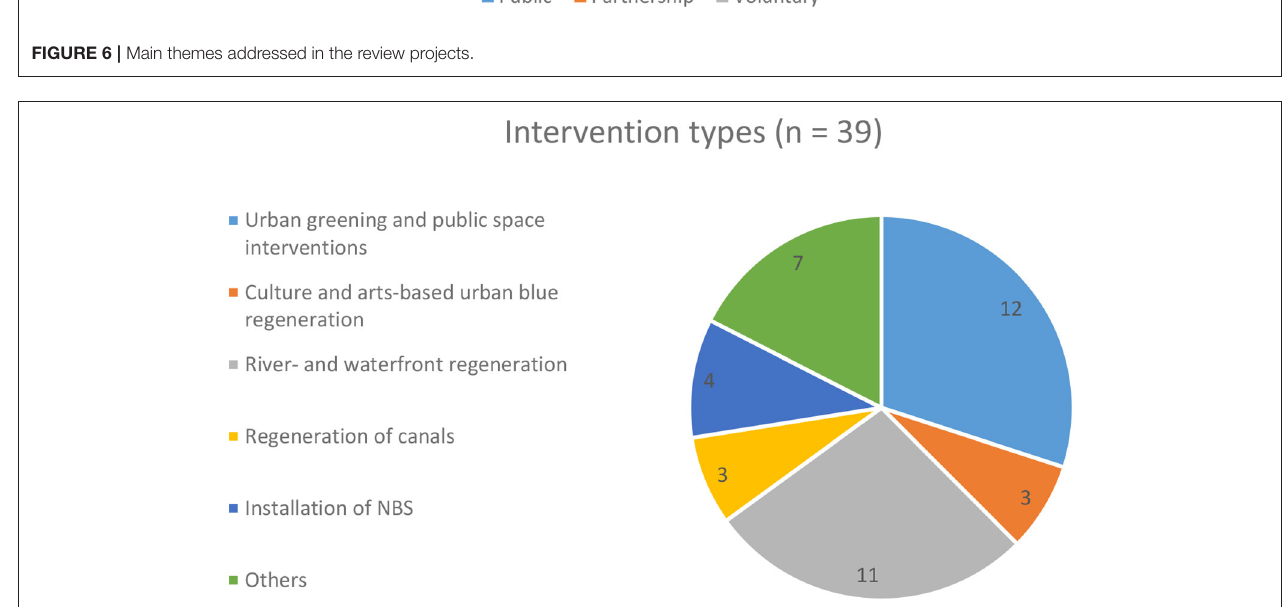
FIGURE 7 | Distribution of projects according to intervention